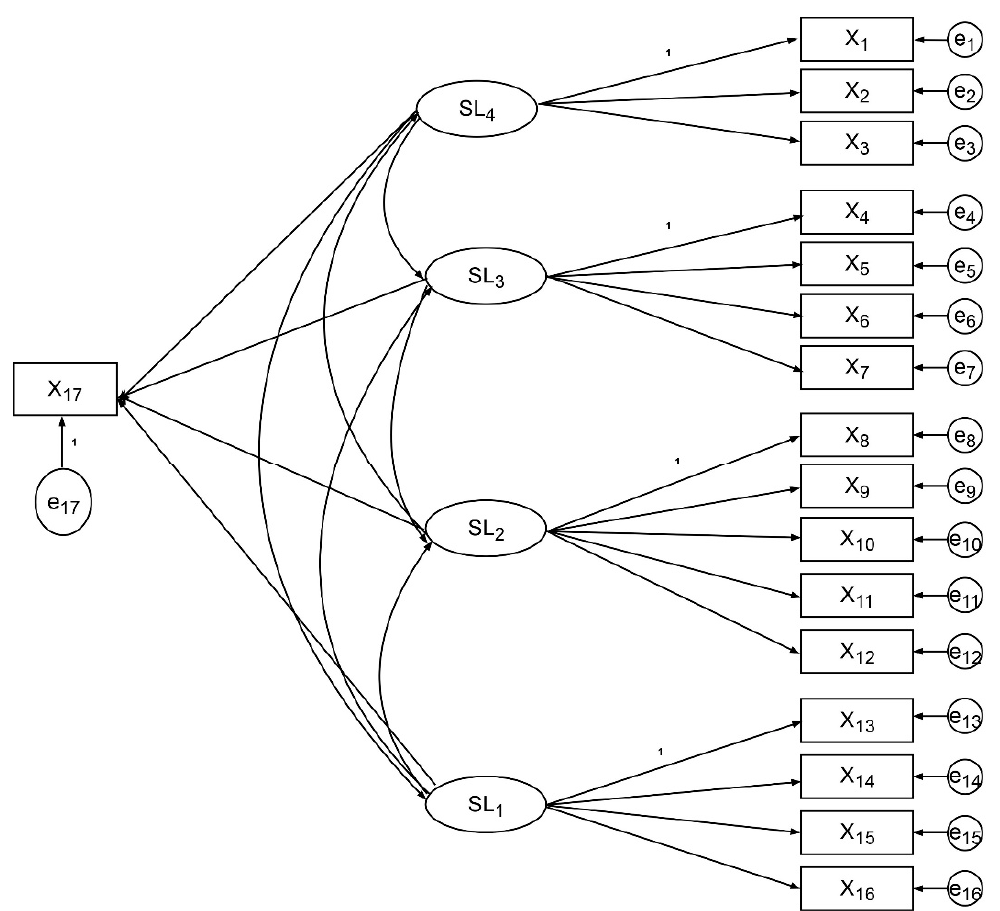
Figure 4. Structural Hypothetical Model of Marine traffic accident.